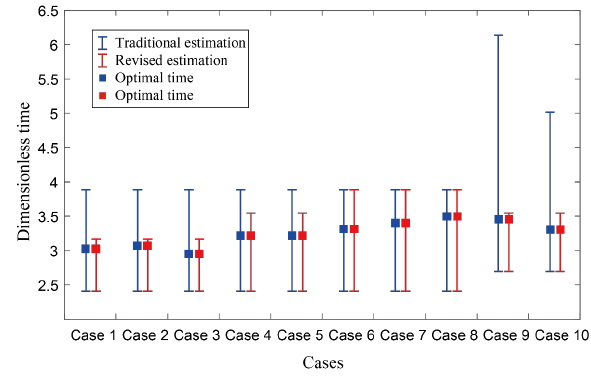
Figure 16. The comparison of the traditional and revised estimation methods in Cases